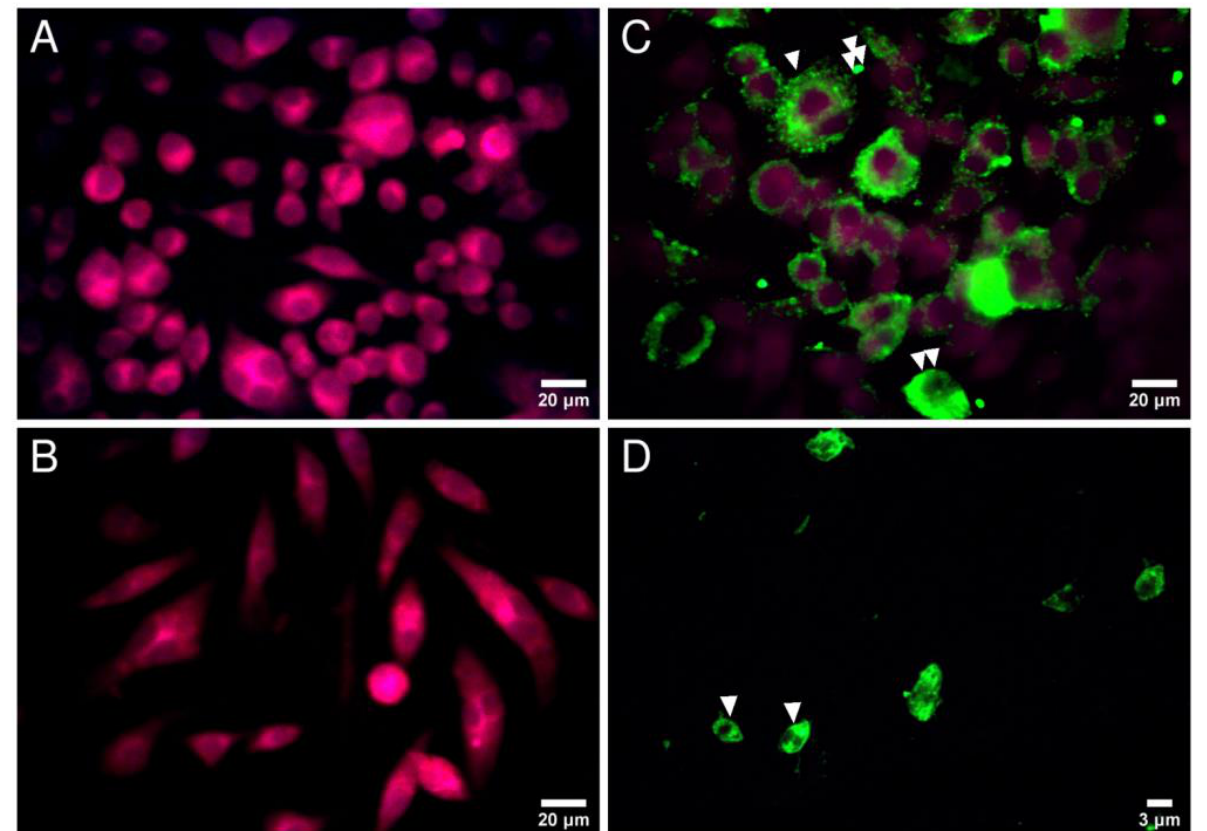
Figure 1. Fluorescence light micrographs of L. major -infected RAW 264.7 cells and corresponding macrophage-derived amastigotes treated with rabbit anti- L. major immune serum and FITC-conjugated goat anti-rabbit IgG. ( A , B ): Control experiments observed by epifluorescence microscopy (×40). A: Noninfected RAW 264.7 cells treated with rabbit anti- L. major immune serum and FITC-conjugated goat anti-rabbit Ig G; B: infected RAW 264.7 cells treated with preimmune serum. ( C ): Leishmania major infected RAW 264.7 cells treated with rabbit anti- L. major immune se- rum and FITC-conjugated goat anti-rabbit IgG and observed by epifluorescence microscopy (×40). A dense speckled cytoplasmic fluorescence (one arrow) and a brilliant surface fluorescence labeling (2 arrows) are shown with RAW cells; amastigotes of L. major appear as extra-cellular fluorescent bodies (3 arrows). ( D ): L. major macrophage-derived amastigotes treated with rabbit anti- L. major immune serum and FITC-conjugated goat anti-rabbit IgG and observed by epifluorescence mi- croscopy (×100).